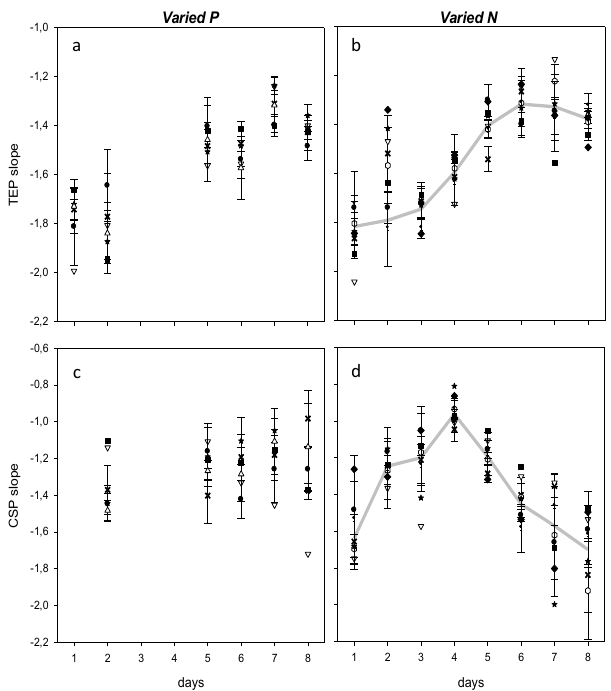
Figure 6. Changes in the slope ( δ) of the size–frequency distribu- tion of TEP (a, b) and CSP (c, d) during the mesocosm blooms. The grey lines indicate the mean value of all mesocosms on the respec- tive day; symbols as in Table